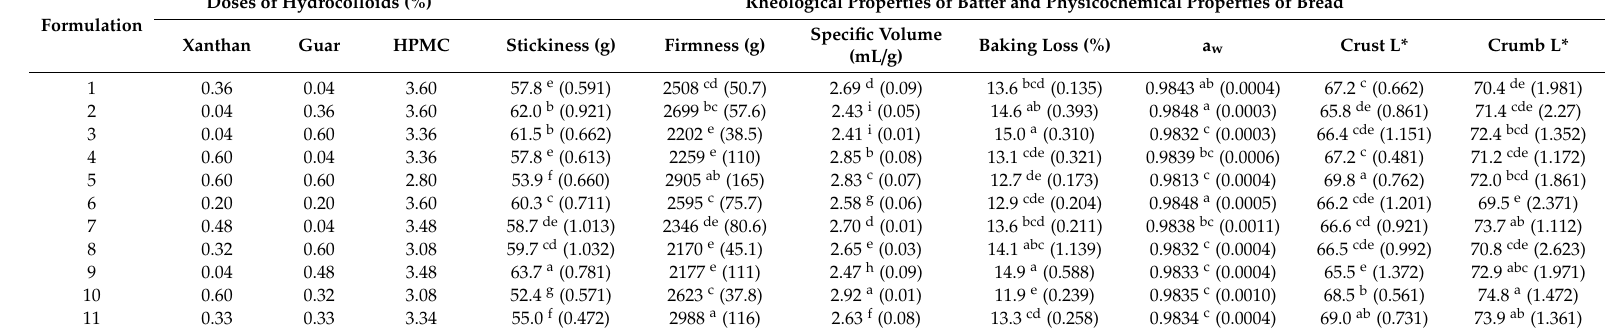
Table 2. Mean values and standard deviations (in brackets) of the gluten-free batter rheological properties of stickiness and firmness and physicochemical properties of gluten-free bread by formulation